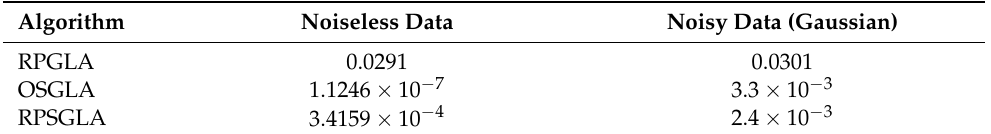
Table 1. The average MSE (repeating 100 times) of the RPGLA, RPSGLA, and OSGLA obtained on noiseless data and noisy data (Gaussian).